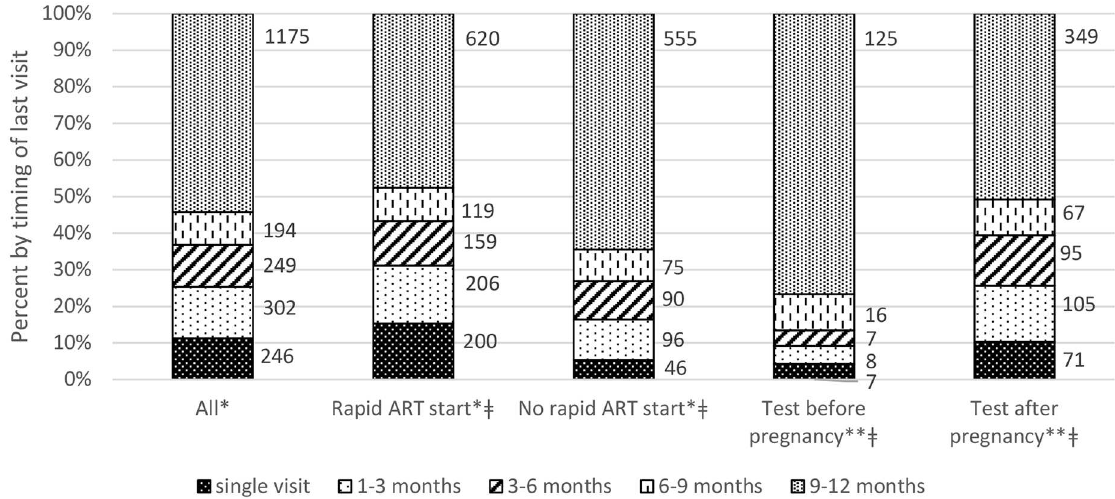
Fig 1. Timing of last visit in 12 months after ART start. * Among2,166 Option B+ clients. ** Among 850 Option B+ clients with known pregnancy and HIV testing dates. RapidART start = ART start within 7 days of registrationin HIV care; No rapid ART start = ART start > 7 days after registration in HIV care. ǂ p < 0.001for Chi2 test of equality of proportions betweenRapid ART start vs. No rapid ART start and betweenHIV test before vs. after start of pregnancy.